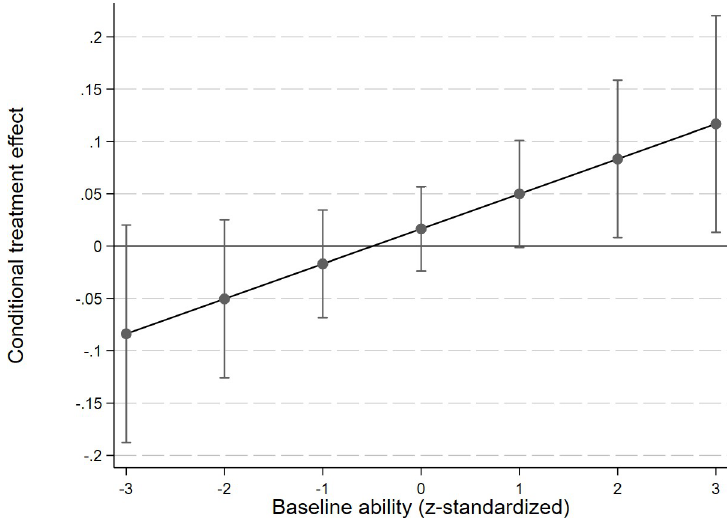
Fig 6. Conditional treatment effect of receiving the encouragement message on students’ endline exam grades, based on students’ baseline ability.